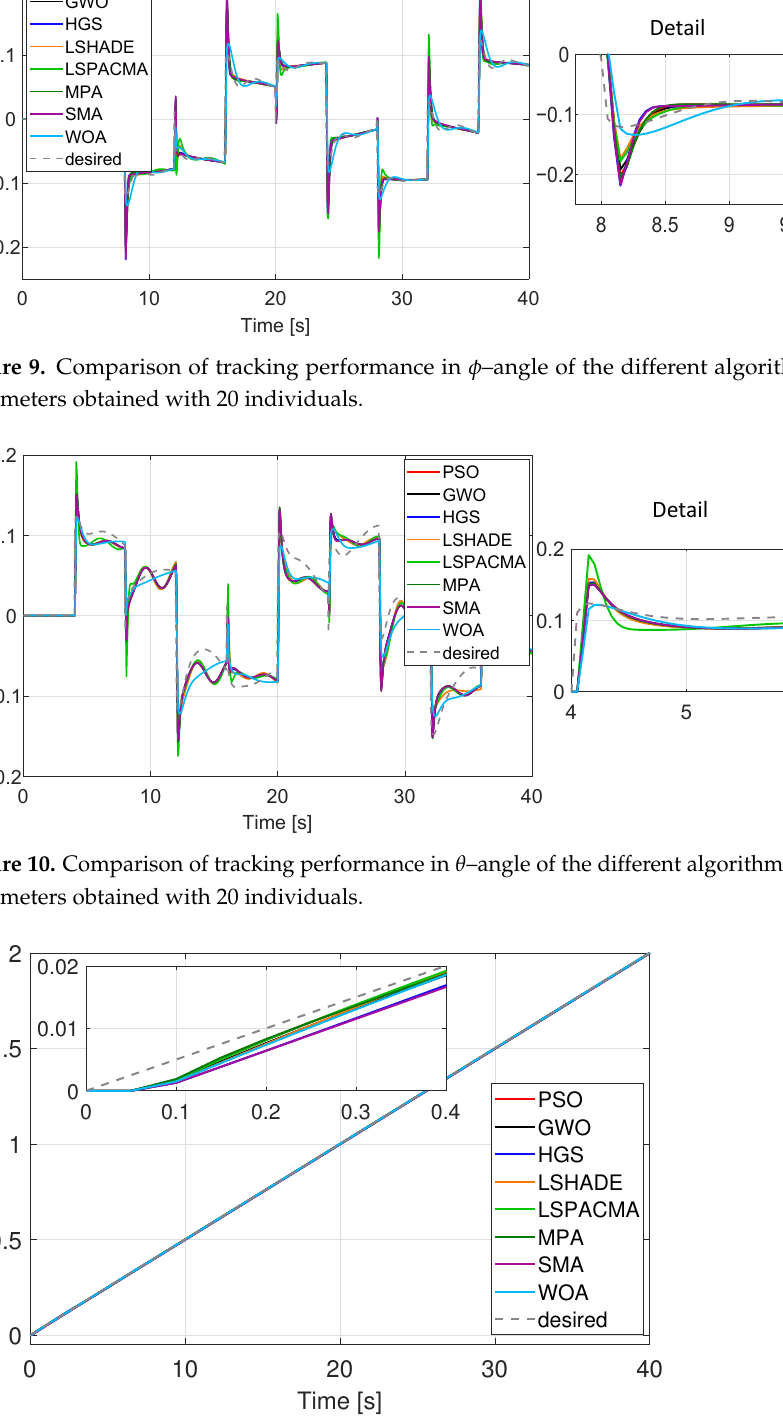
Figure 11. Comparison of tracking performance in ψ –angle of the different algorithms evaluating the parameters obtained with 20